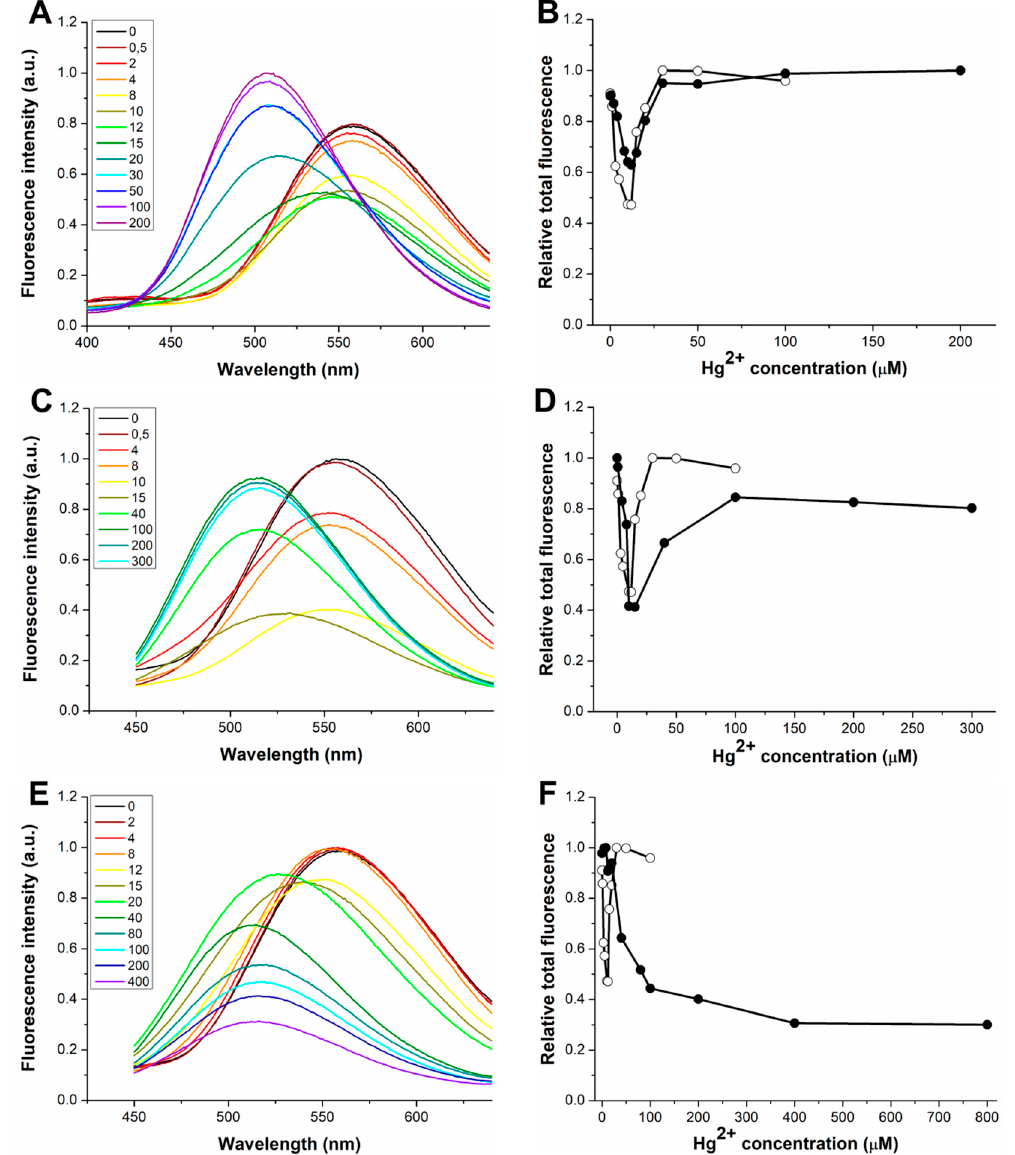
Figure 5. Fluorescence response of dH3w(H1A), dH3w(H3A), and dH3w(H5A) as function of Hg(II) concentration. Emission spectra of ( A ) dH3w(H1A), ( C ) dH3w(H3A), and ( E ) dH3w(H5A). The legends show the concentrations of Hg(II) in µ M units. Normalized area of the fluorescence emission as function of the Hg(II) concentration for ( B ) dH3w(H1A), ( D ) dH3w(H3A), and ( F ) dH3w(H5A) (filled circles). For comparison, the normalized area of the fluorescence emission of dH3w is also reported in each panel (void circles). Spectra were registered after excitation at 340 nm (the absorption maximum of the dansyl group) in 20 mM MOPS buffer, pH 7 at 25 °C.